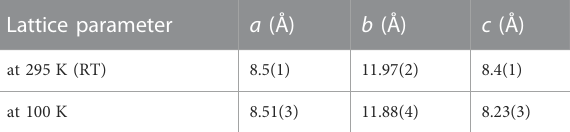
TABLE 2 Lattice parameters of CsPbBr 3 nanocrystals determined from electron powder diffraction at room temperature (RT) and at 100 K (with liquid nitrogen